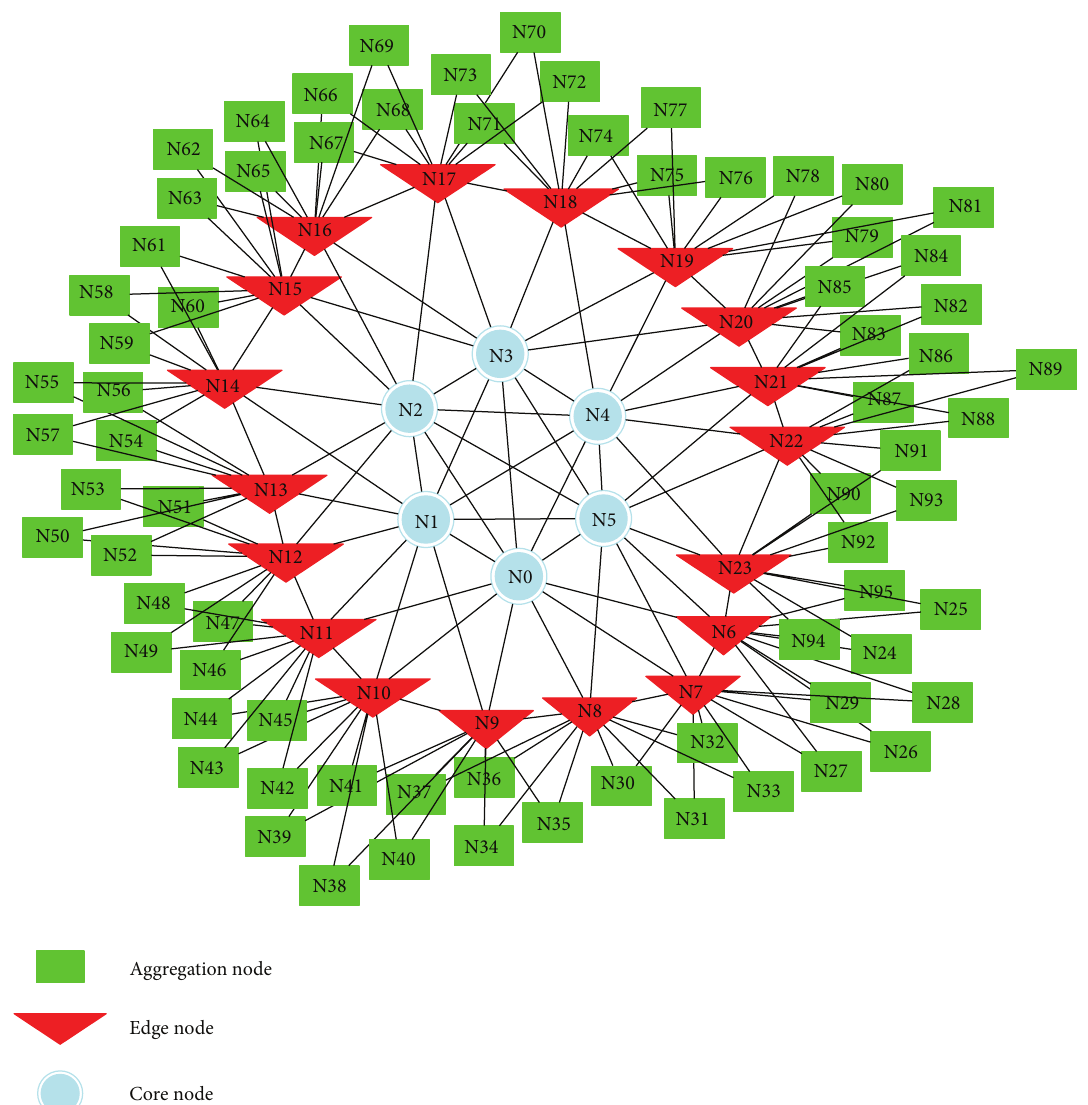
Figure 3: Hierarchical Network topology with 𝑥 = 6 , 𝑦 = 3 , and 𝑧 = 4 .